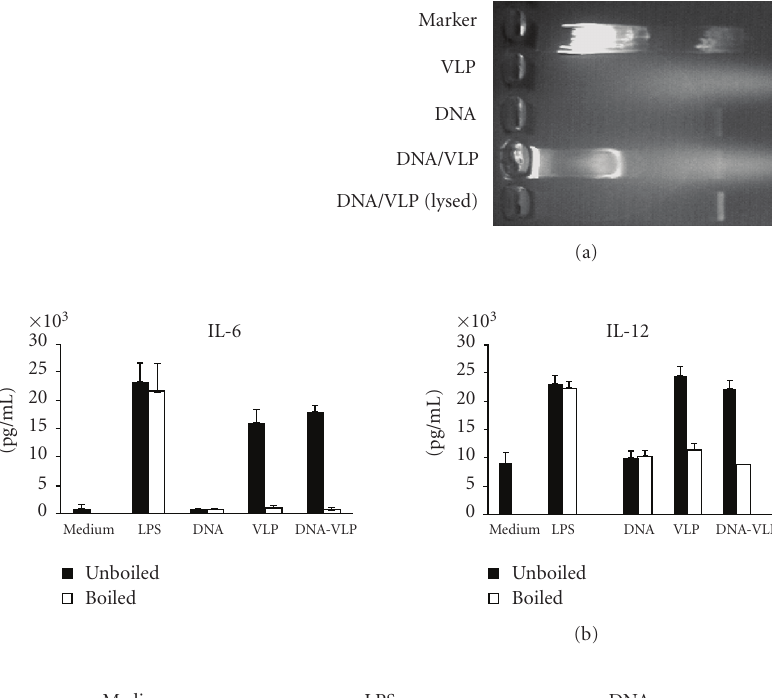
HIV Env-DNA (50 μ g/mL) and SHIV 89.6 VLPs (10 μ g/mL). (c) Maturation of BMDCs after stimulation by SHIV 89.6 VLP vaccines. BMDCs